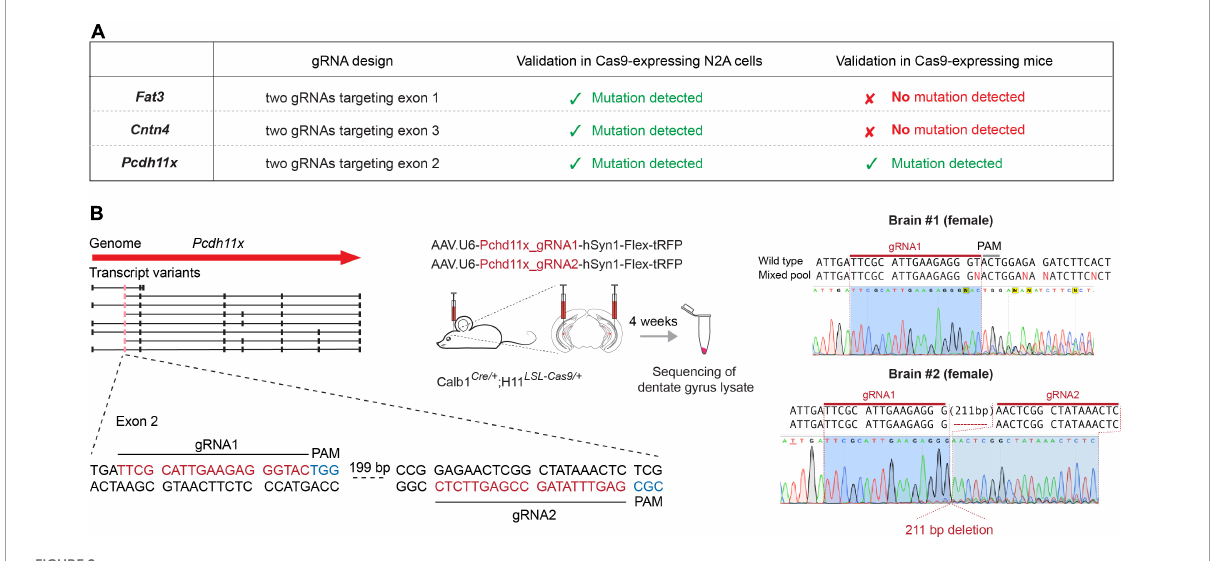
FIGURE2 Genomic targeting of CAMs in adult GCs. (A) Schematic representation of the genome targeting approach for Fat3 , Cntn4 , and Pcdh11x . Table shows targeted exons and the presence or absence of mutations during cell culture (Cas9-expressing N2A cells) and in vivo (Cas9-expressing mice) validation. (B) In vivo genomic targeting of Pcdh11x . Left panel shows specific gRNA design and experimental schedule. Right panel shows sequence maps of detected mutations and/or deletions in dentate gyrus lysates prepared from two different